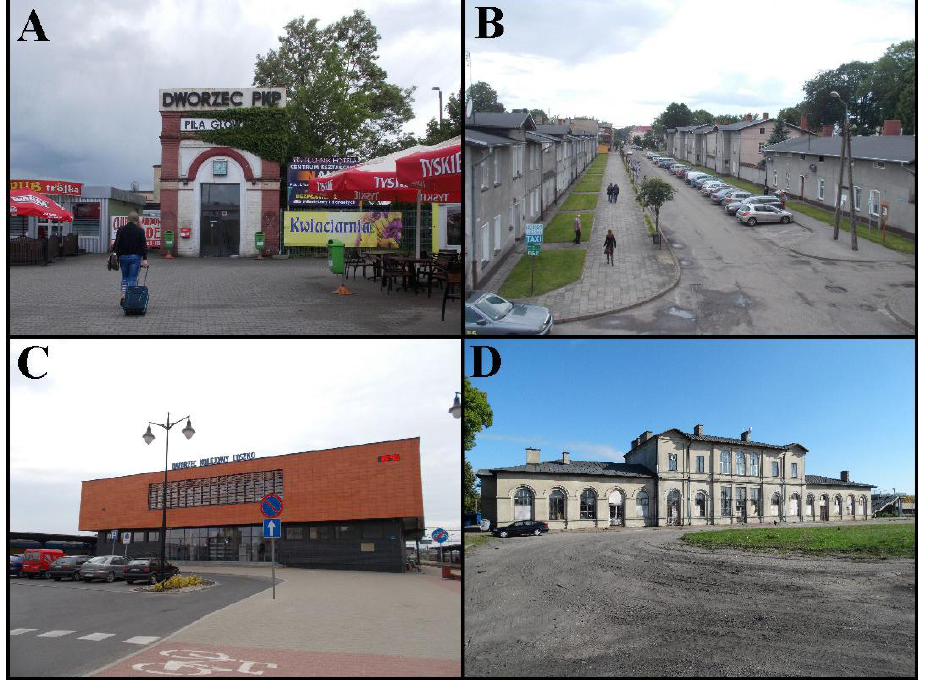
Fig. 3. Diversified spatial development around island railway stations in Piła (A), Krzyż Wielkopolski (B), Leszno (C) and Grajewo (D)